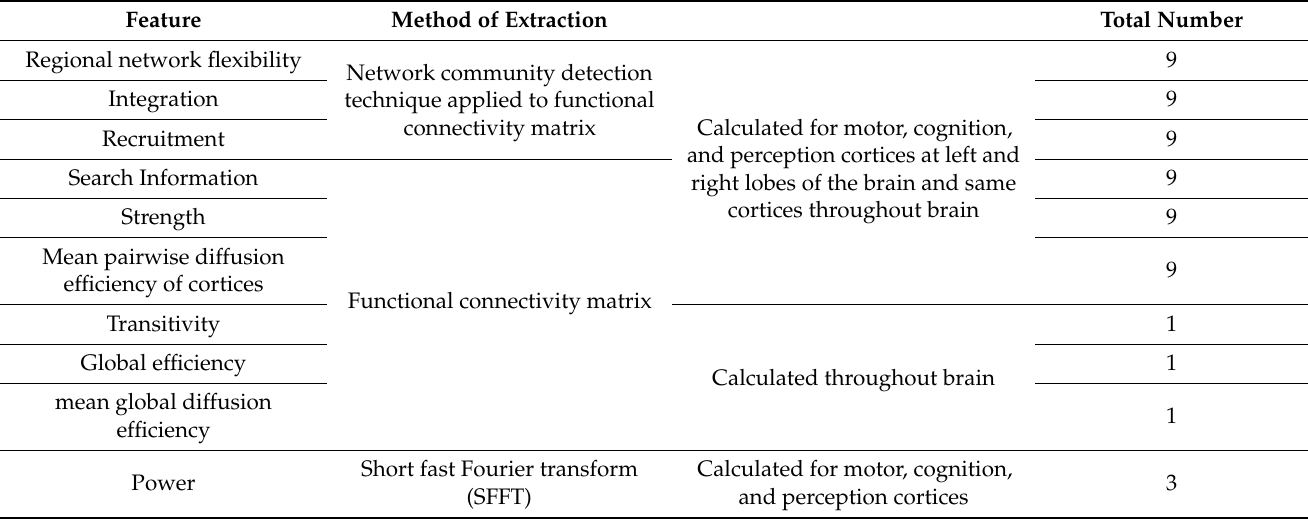
Table 3. Summary of extracted